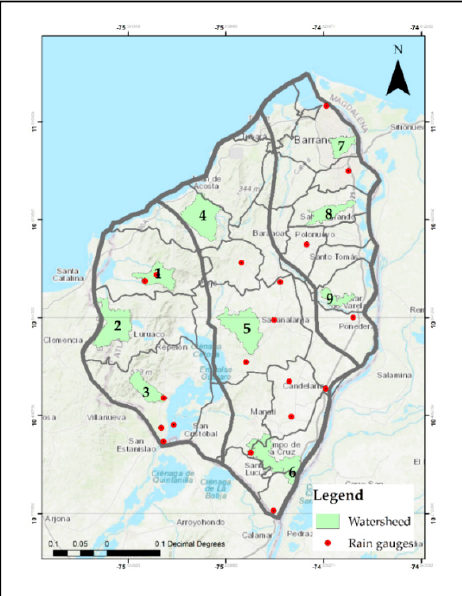
Figure 11. Delimited homogeneous regions. Table 9. Information about watershed used. ID—identifier.